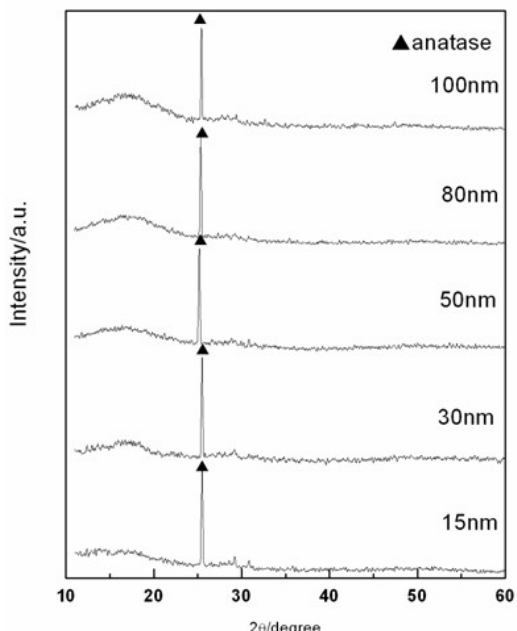
Figure 2. XRD analysis of TNT. All samples are found to be anatase in an amorphous background.